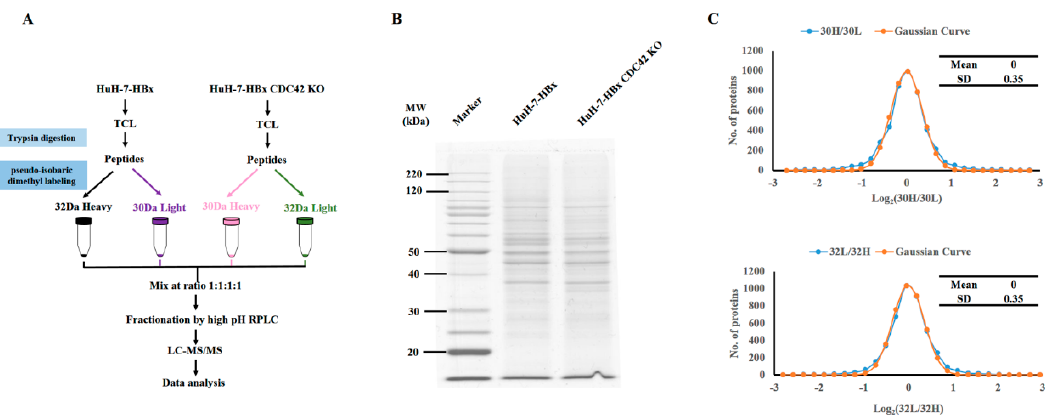
Figure 5. Quantitative proteomics strategies and acquisition of high quality proteomic data. ( A ) Experimental procedures of the quantitative proteomic analysis in this study. TCL, total cell lysate; ( B ) Samples were resolved by SDS-PAGE and stained with Coomassie blue, indicating that a high quality and an equal starting amount of protein was prepared; ( C ) Distributions of Log 2 (30H/30L) were symmetrical and could be fit to a Gaussian curve, and the value of Standard Deviation (SD) was 0.35, the same as that of Log 2 (32L/32H).